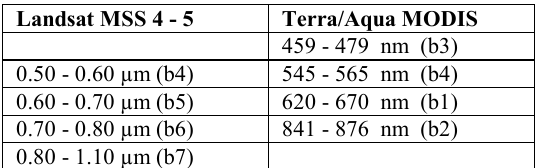
Table 2. Similarities in spectral bandwidth between Landsat MSS and MODIS systems.